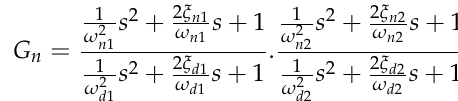
a replaceable one. Figure 13. The dynamic pressure feedback (DPF) controlled system model illustration. A nonlinear PID is used to improve the tracking accuracy in the low frequency band, i.e., around 1~5 rad/s, with a piecewise proportional gain presented as Equation (21). 𝐾 (cid:3017) (cid:3435)𝑒(𝑡)(cid:3439) = (cid:3420)𝑓 (cid:3012) ∙ 𝐾 (cid:3017) (𝑓 (cid:3012) > 1) |𝑒(𝑡)| ≤ 𝑒 (cid:3041) 𝐾 (cid:3017)